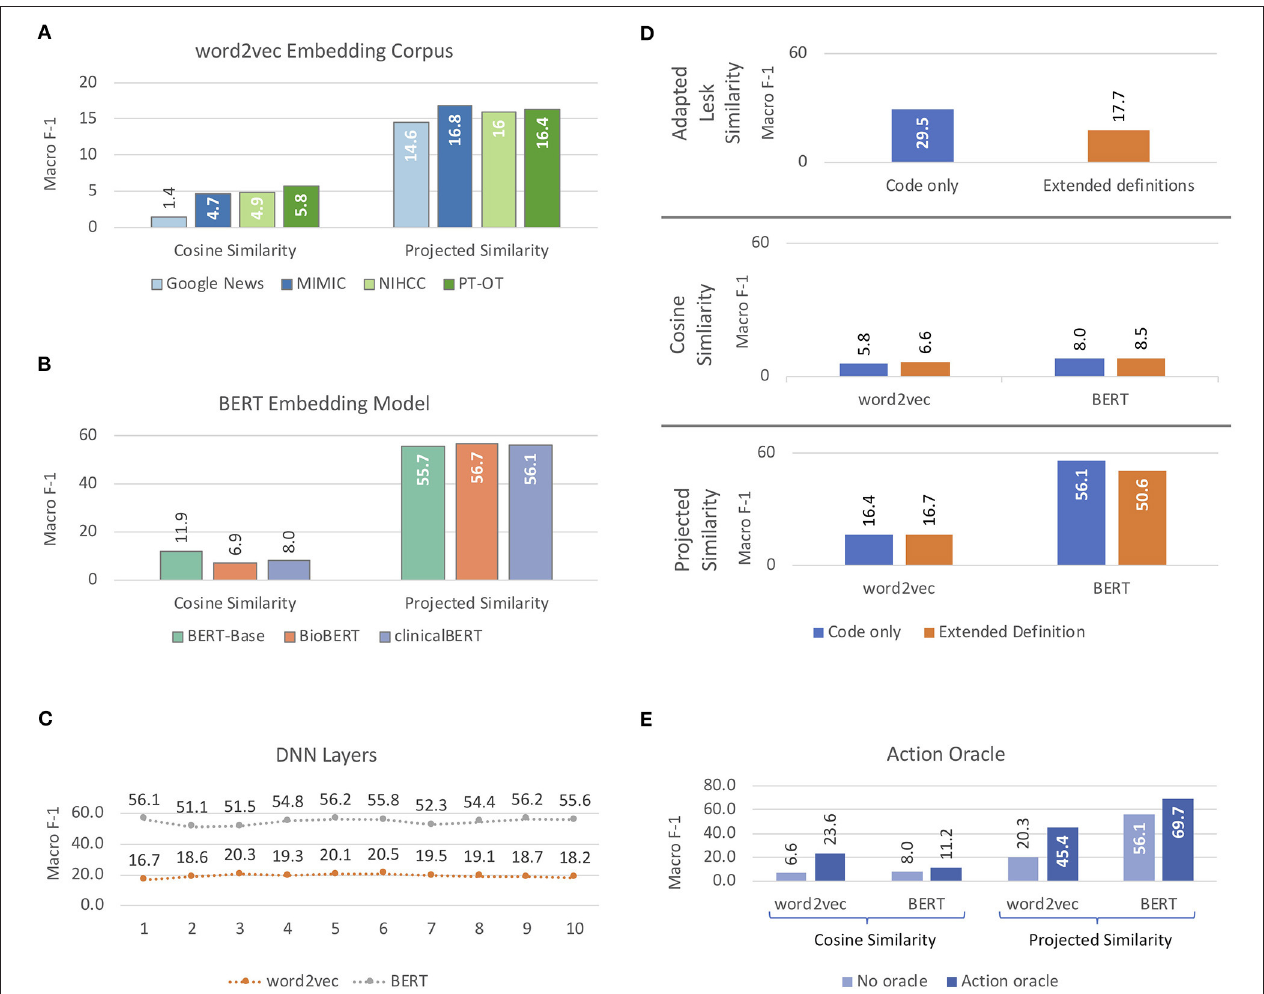
FIGURE 6 | Macro-averaged F-1 performance, reported on development data, on candidate selection approaches to coding activity reports according to the ICF. (A,B) report on selection of embedding models for word2vec and BERT features, respectively. (C) reports results of projected similarity experiments with different numbers of hidden layers in the Deep Neural Network (DNN) component. (D) illustrates results using 3-digit ICF code definitions with and without extended definitions, and (E) shows results for cosine similarity and projected similarity models with and without the Action